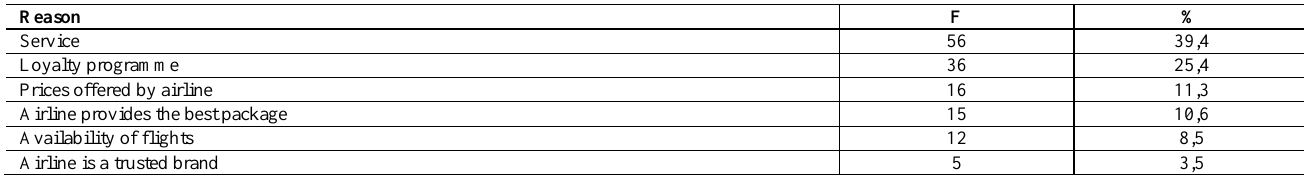
Table 3: Reasons for not forming a long-term relationship with the domestic airline Reason